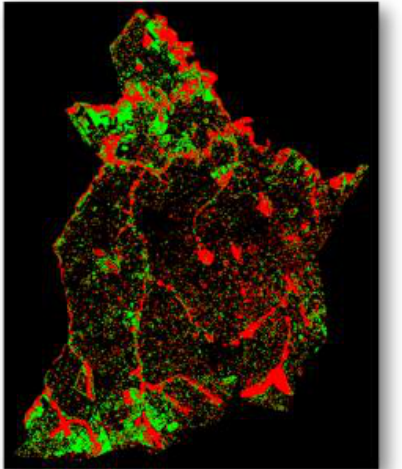
Figure 10 – Classification by the Minimum Distance method: Significant Change (green), and Small Change (red) .